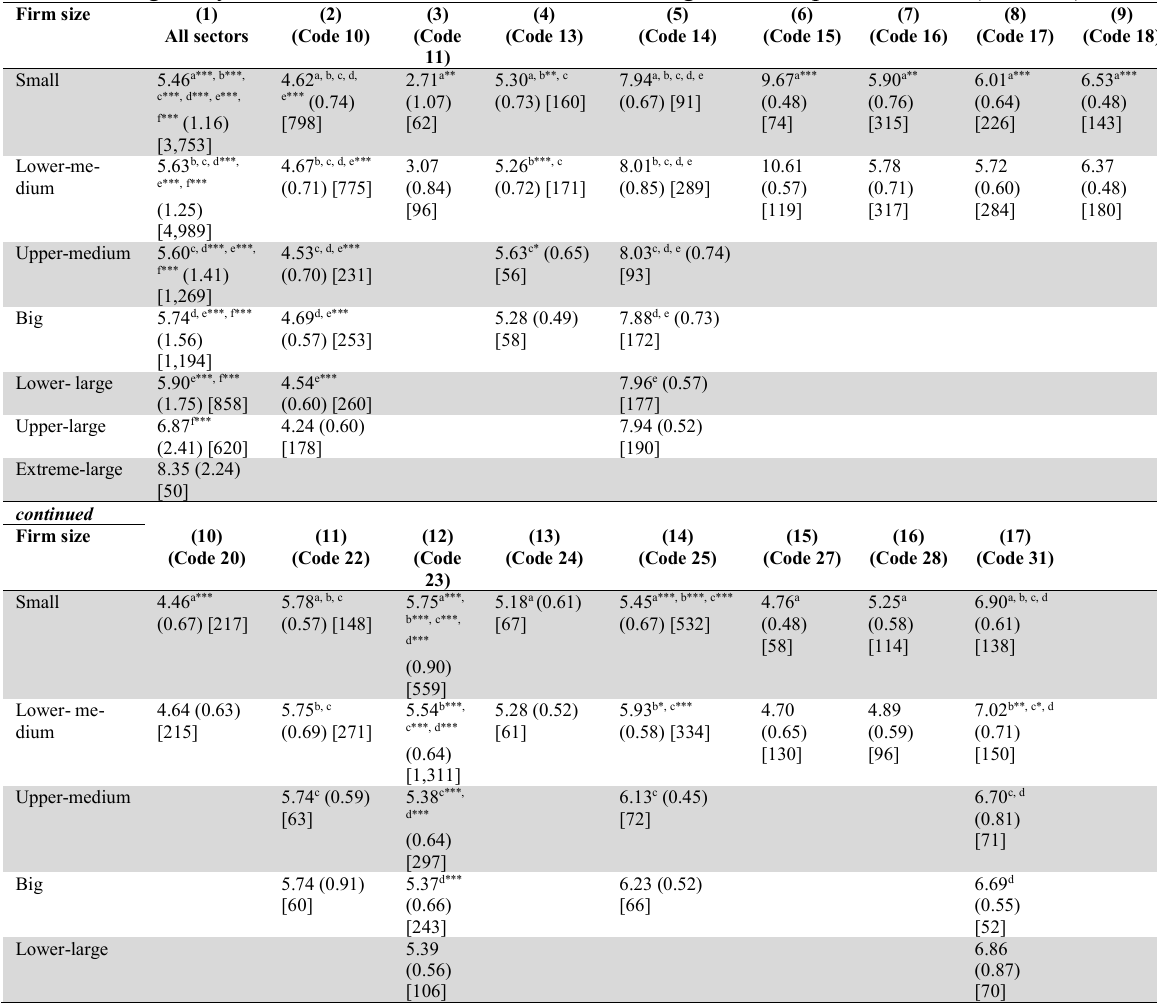
Note: Standard error in the parentheses, number of observations in the square brackets. ***, **, *: The averages are statistically different at the 1%, 5%, 10% level. For multiple groups, the stars on 1 st , 2 nd and 3 rd and so on groups from the top represent the averages between 1 st and 2 nd , 1 st and 3 rd , and 1 st and 4 th groups and so on are statistically different, respectively. For example: a, b, c, d, e, f in column (1) denotes the difference between small firms and lower-medium firms, upper-medium firms, big firms, lower-large firms, upper-large firms, and extreme-large firms, respectively. The signal a in column (3) denotes the difference between small firms and lower-medium firms only. Industry codes are as follows: 10: Food products; 11: Beverages; 13: Textiles; 14: Wearing apparel; 15: Leather and related products; 16: Wood and products of wood/cork; 17: Paper and paper products; 18: Printing and reproduction of recorded media; 20: Chemicals and chemical products; 22: Rubber and plastics products; 23: Other non-metallic mineral products; 24: Basic metals; 25: Fabricated metal products; 27: Electrical equipment; 28: Machinery and equipment n.e.c; 31: Furniture. Source: Authors’ estimation from VAES